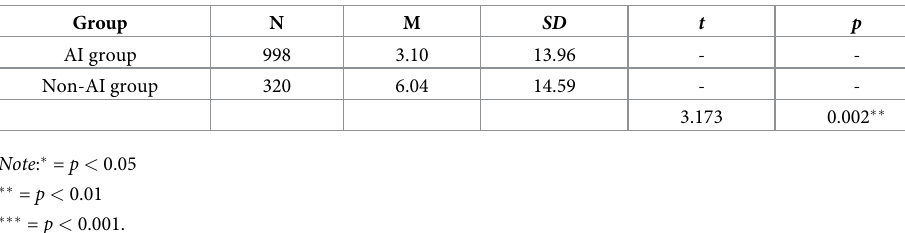
Table 1. Differences in social adaptability of students between AI group and non-AI